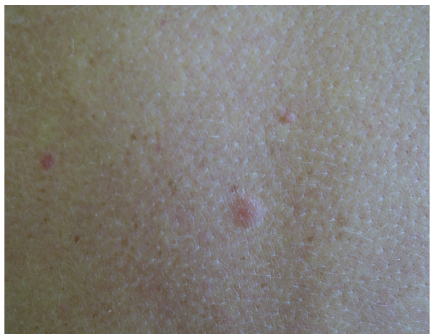
Figure 1: Multiple firm tender reddish nodules on the arms.